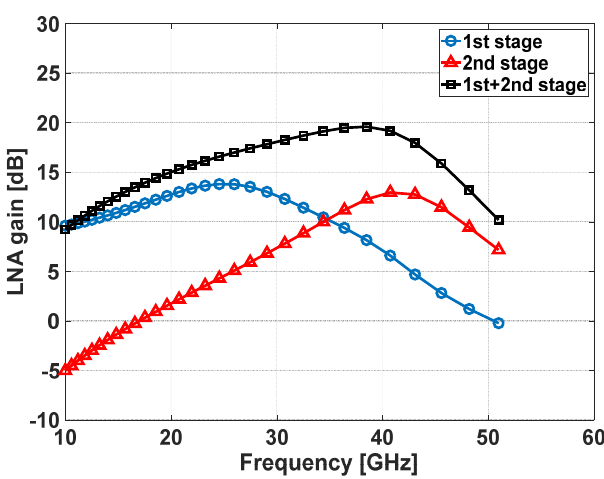
Figure 5. The simulated frequency response of the LNA with stagger tuning.